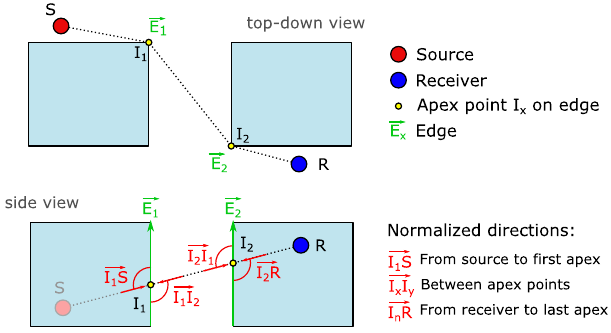
Figure 3. Constraint of equal incoming and outgoing diffrac- tion angles and the relationship between direction vectors shown as top-down and side view of a two-building scene with an elevated